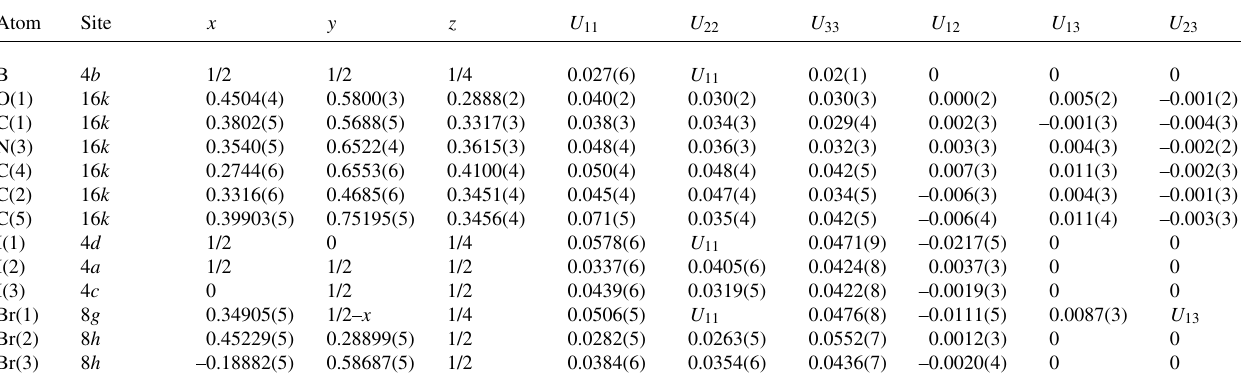
Table 3. Atomic coordinates and displacement parameters (in Å 2 ) .